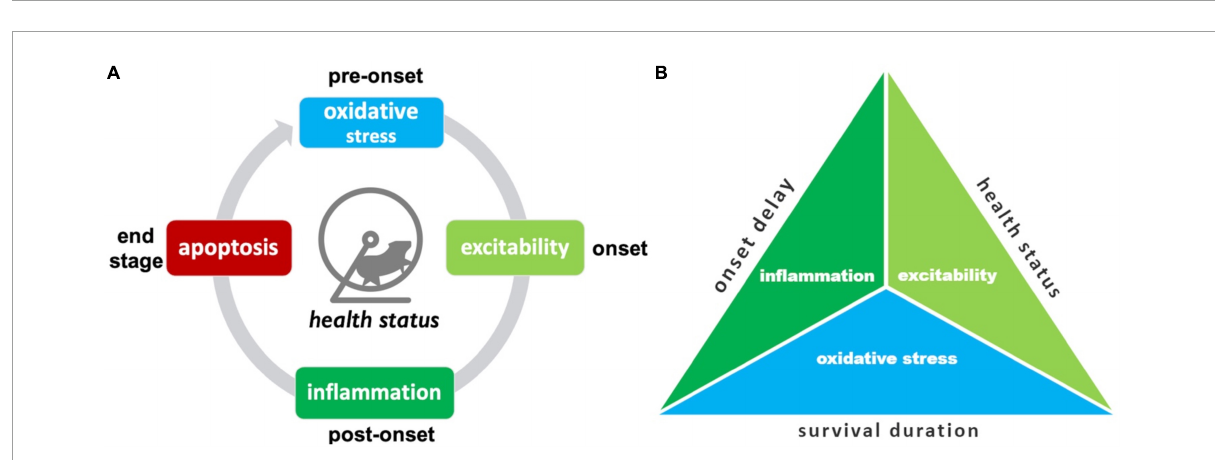
FIGURE7 Comparison of the treatment effects of monotherapy and polytherapy. Polytherapy significantly ( p < 0.05) outperformed monotherapy monotherapy at end stage (131 + days). *Represents p < 0.05.